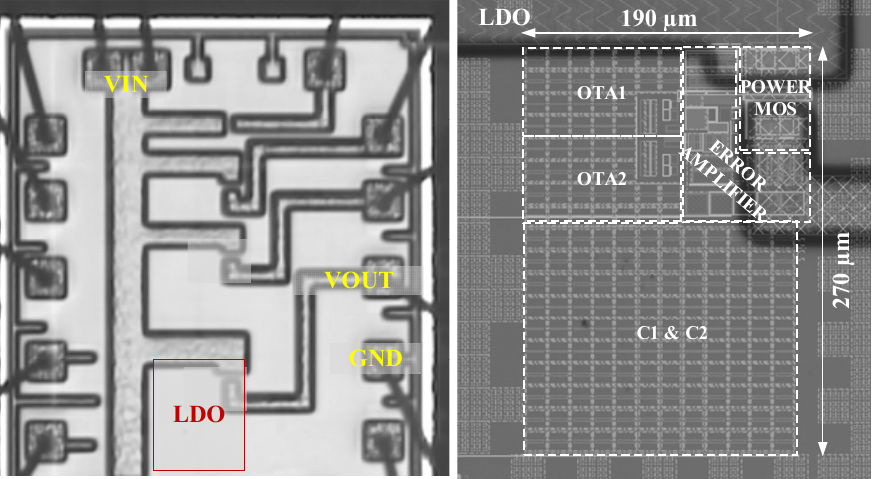
Figure 19. Micrograph of the test ‐ chip section the proposed LDO was integrated in and a zoom ‐ in that provides the LDO floorplan.